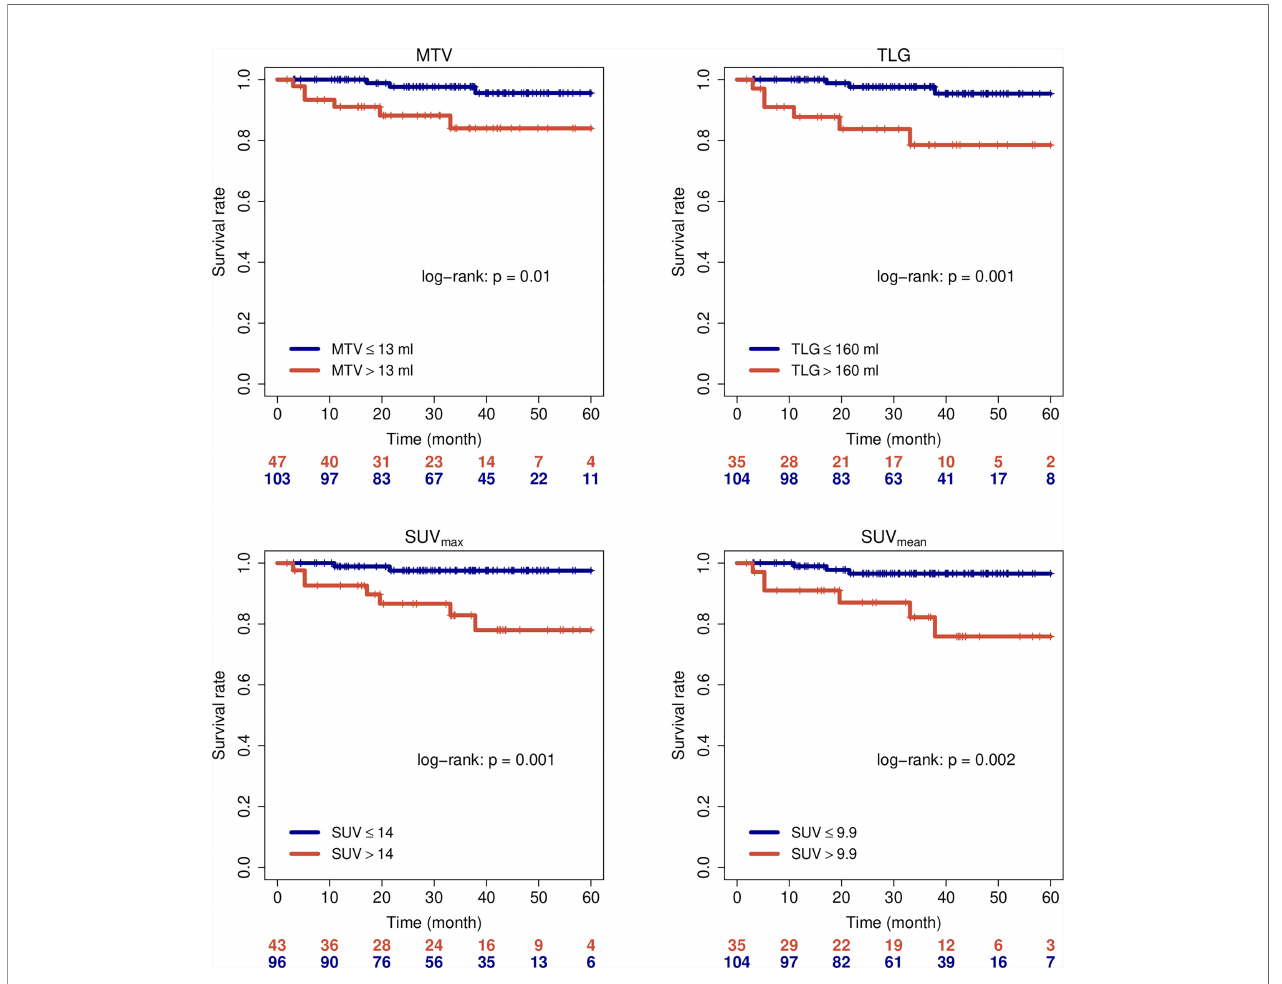
FIGURE 5 | Loco-regional control of HPV-positive oropharyngeal carcinomas when strati fi ed by PET